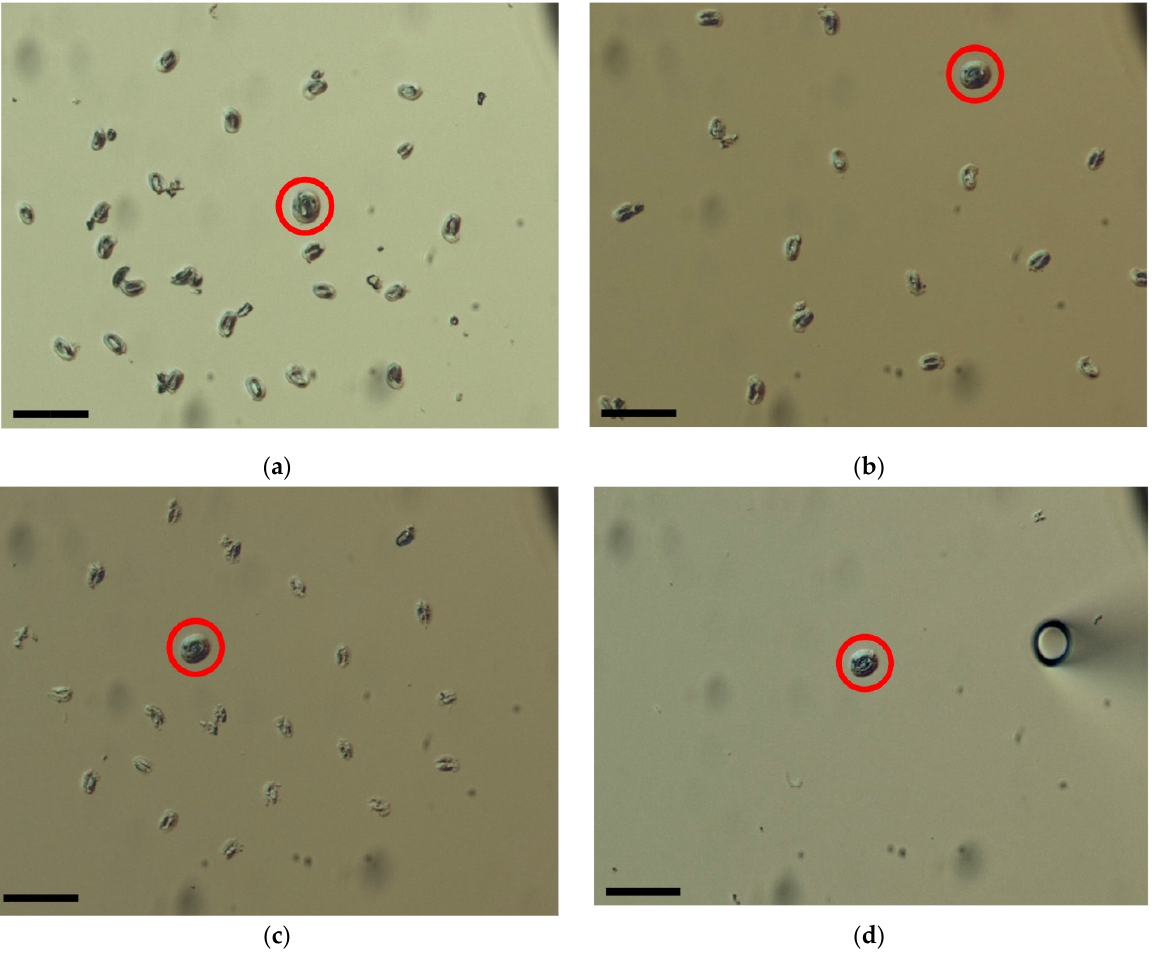
Figure 5. Etching and dissolution of picked coccoliths of H. carteri deposited in a solution with pH = 9. For reference, one coccolith of the species Coccolithus braarudii highly resistant to dissolution has been placed in the field of view (red circle). ( a ) Freshly picked coccoliths in well-preserved state; ( b ) Coccolith etching after 55 min; ( c ) Coccolith dissolution after 74 min; ( d ) Coccoliths completely dissolved after 90 min. Scale bars are 20 µm.